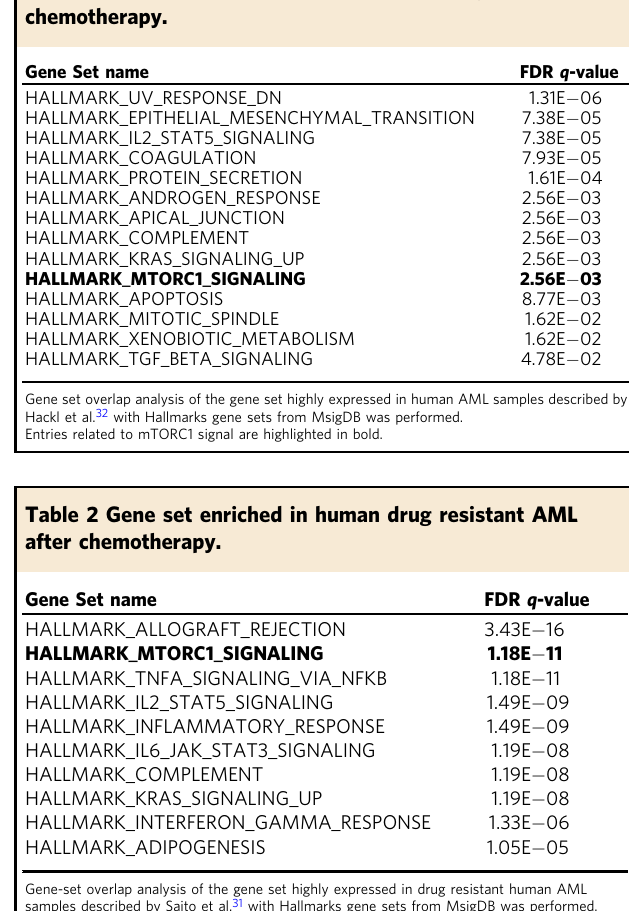
Fig. 4 mTORC1 activity dynamics during chemotherapy. a Experimental work fl ow of bone marrow harvest in relationship to chemotherapy administration (day 0: fi rst day of treatment). b Relative of AML burden without (NT) or after chemotherapy (day 5, 7, 10, and 14). The numbers were normalized to the values at NT ( n = 28, 8, 12, 6, 4, respectively). c Representative intravital imaging of z-projection of the entire calvarial bone marrow with a 2-photon microscope of a FM4-Venus/TOSI transplanted mouse before (day 0) and after chemotherapy (day 5 and 7). Red (mVenus − /TdTomato + ): mTORC1 high area, Yellow (mVenus + /TdTomato + ): mTORC1 low area. Multiple z-projection images are stitched together to show a large area of the calvarial bone